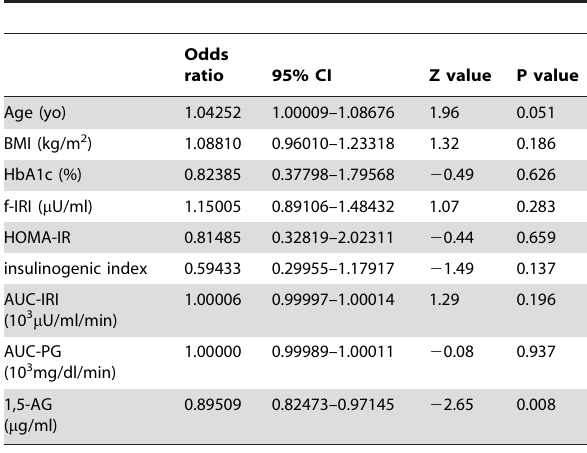
Table 3. Factors associated with progression of hepatic fibrosis in multivariate logistic regression